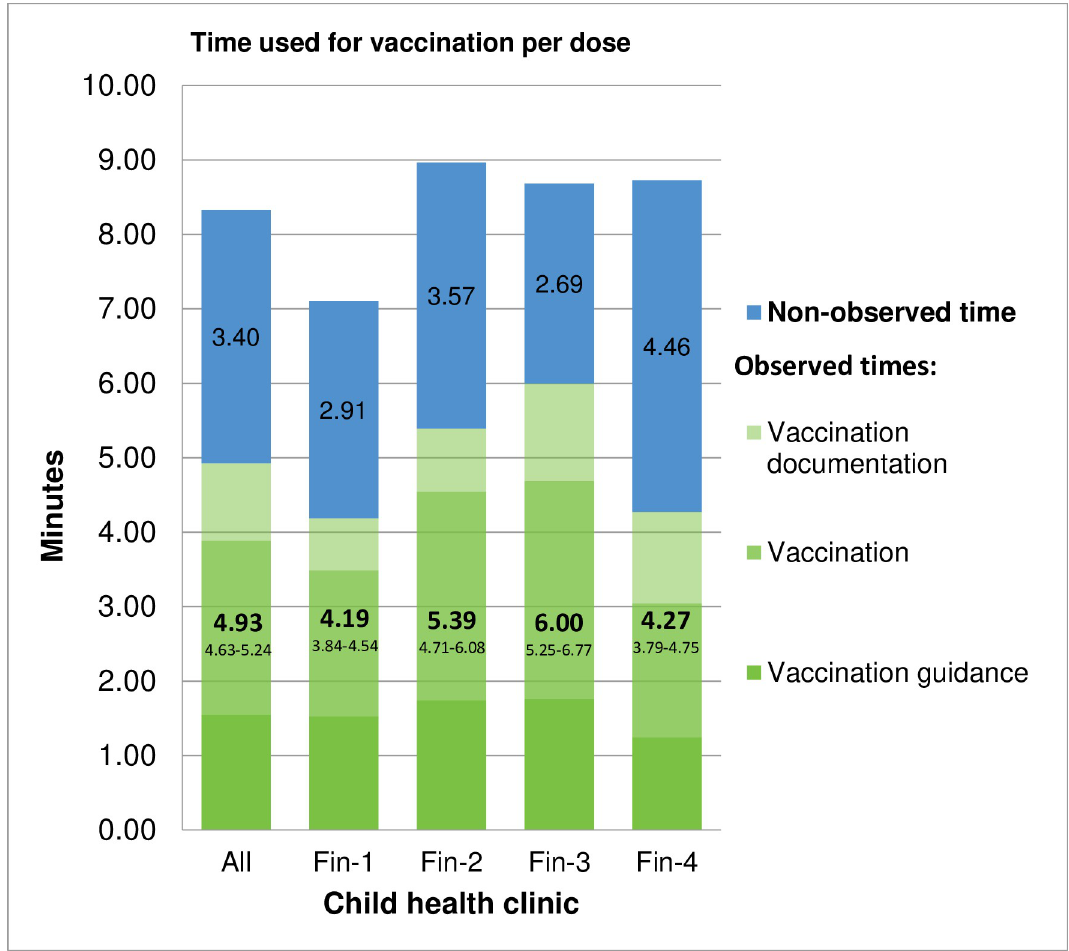
Fig 4. The observed and non-observed time used for one vaccination dose in different child health clinics. (Table 5). Of the injected vaccines, the fully liquid vaccines (pneumococcal conjugate, hepatitis B and seasonal influenza vaccines) were quicker to prepare when compared to vaccines that needed reconstitution (diphteria-tetanus-pertussis-polio- Haemophilus influenzae type B and measles-mumps-rubella -vaccines) (Table 5).